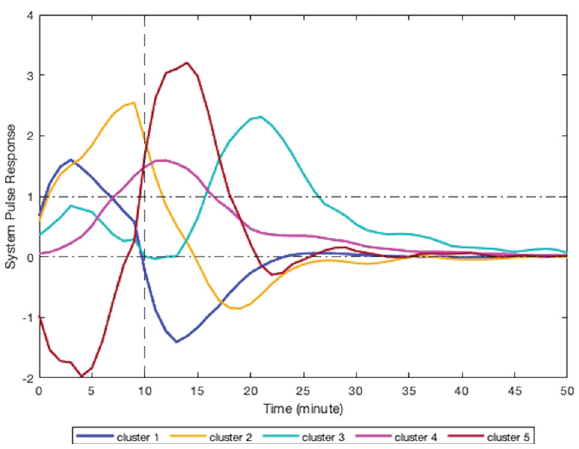
Fig. 4 Pulse response of a representative of all clusters. The vertical line at the 10-min mark on the x -axis re fl ects the time when the stress probability returned to zero.